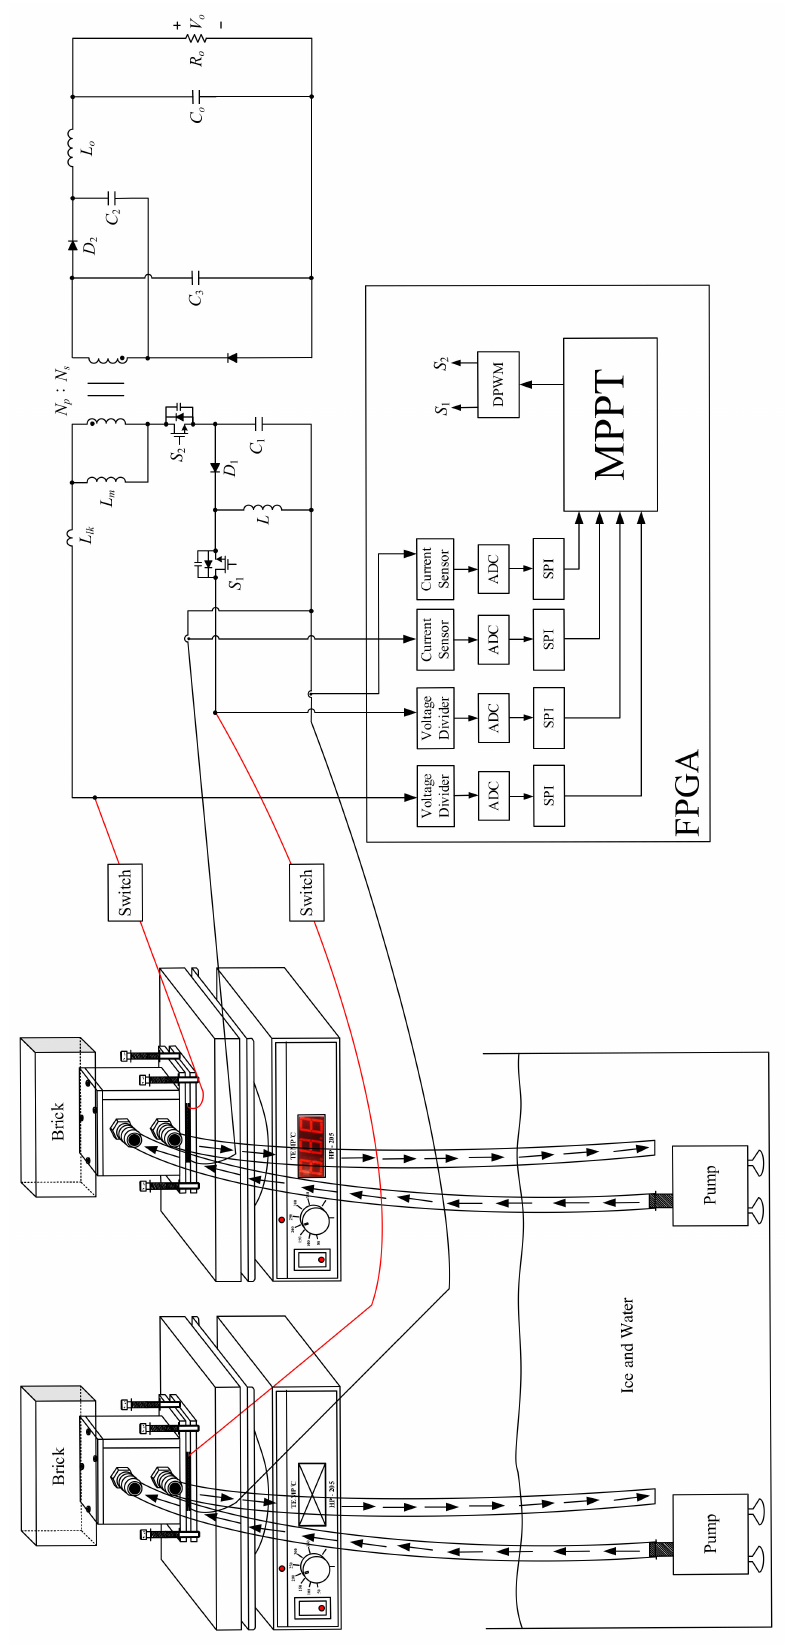
Figure 16. Thermoelectric system with the proposed isolated